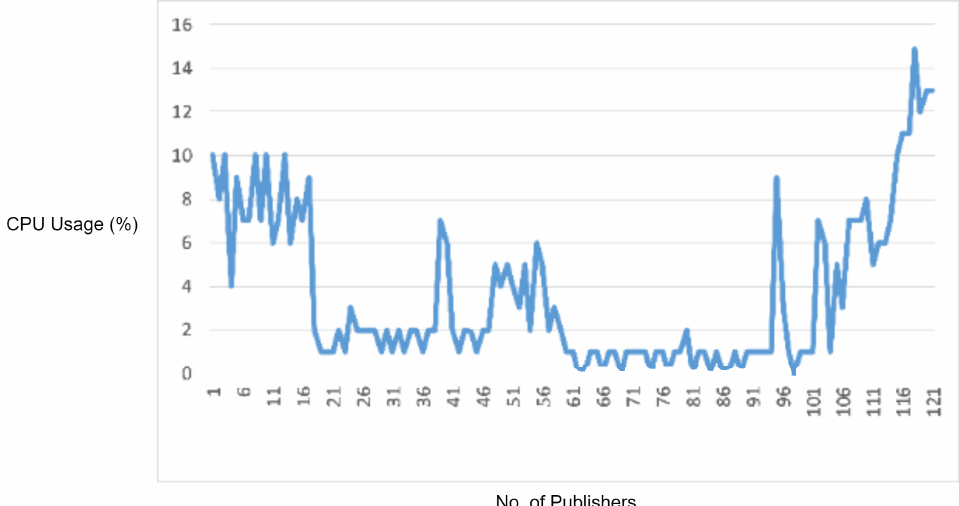
Figure 17. CPU usage captured while performing MQTT DDoS attack when IDS rules are